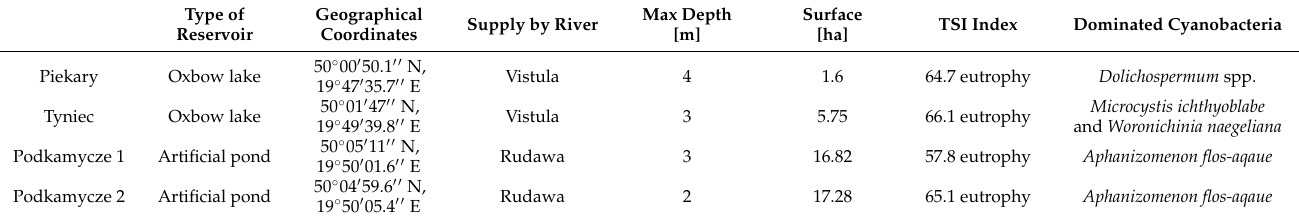
Table 1. Basic information on water bodies. Mean TSI values calculated for chlorophyll a. Thresholds for TSI according to [30]: oligotrophy < 40, mesotrophy 40–50, eutrophy 50–70, hypertrophic >